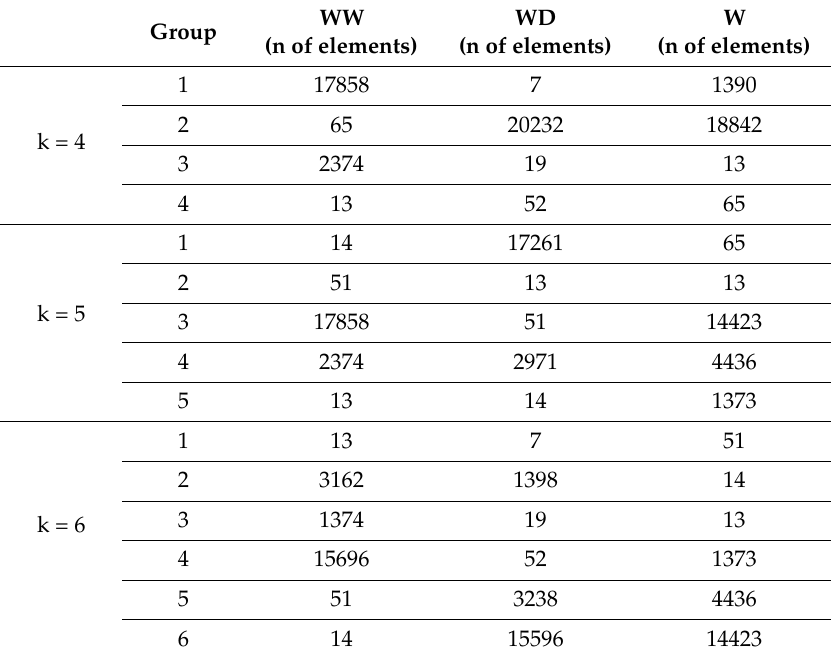
Table 4. Results for k = 4 to k = 6 to all scenarios.